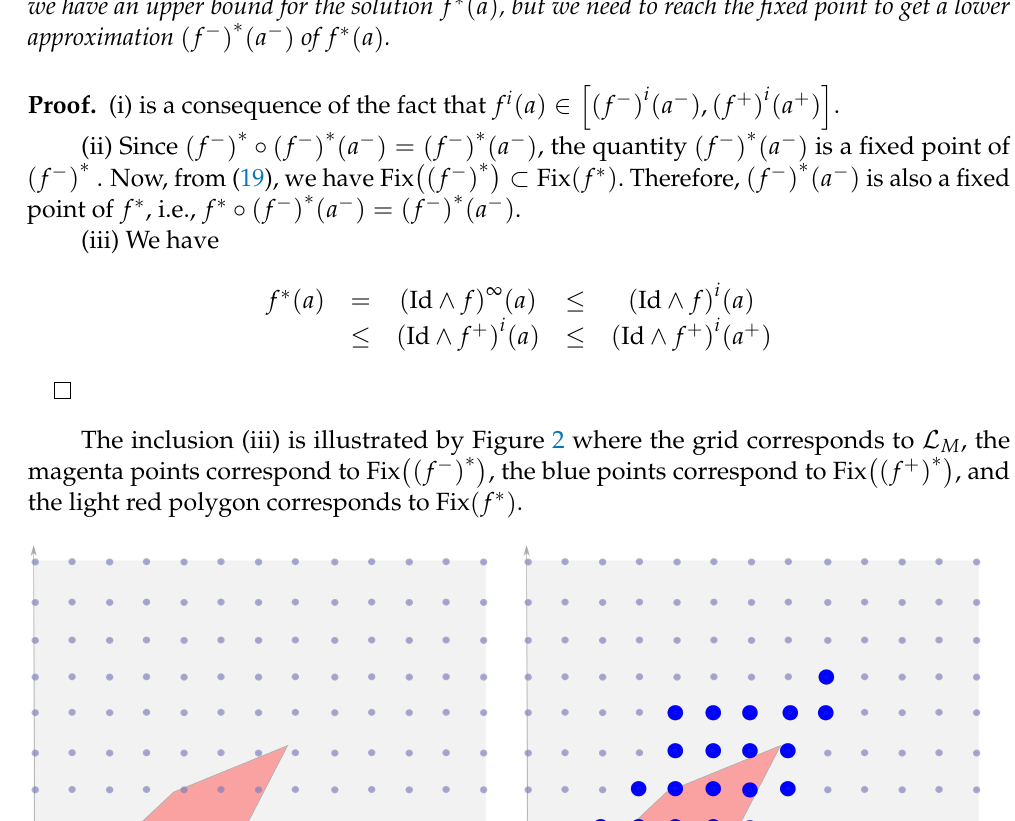
(cid:16)(cid:0) (cid:1) ∗ (cid:17) f − in magenta, Fix